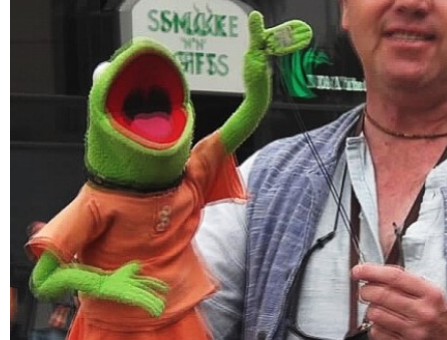
Figure 2 . Muppet Devotion.